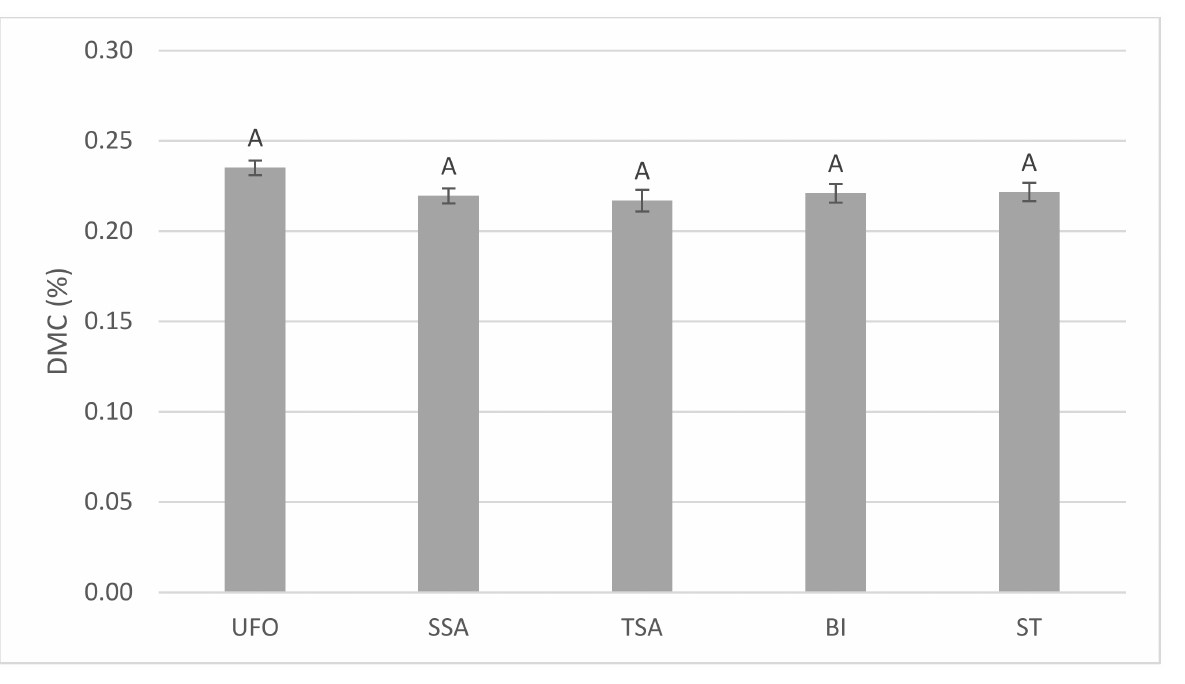
Figure A6. Average fruit DMC of sweet cherry cultivar ‘Kordia’ in different training systems and seasons. Different letters above the means indicate significant difference ( p ≤ 0.05) between training